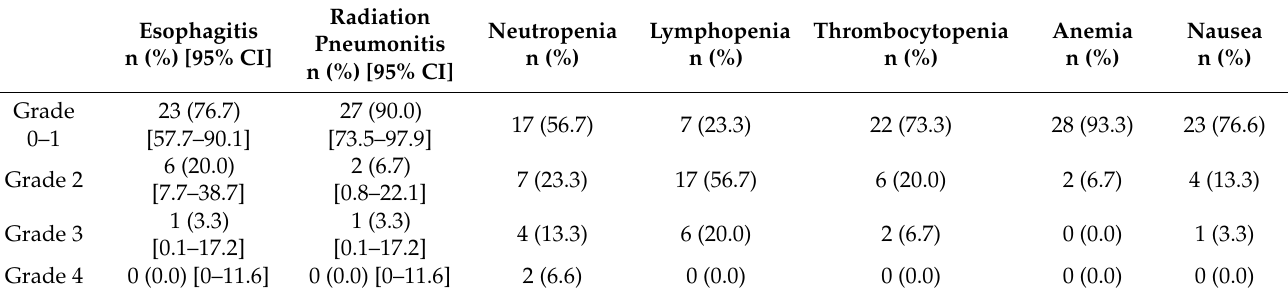
Table 3. Acute radiation esophagitis and other toxic